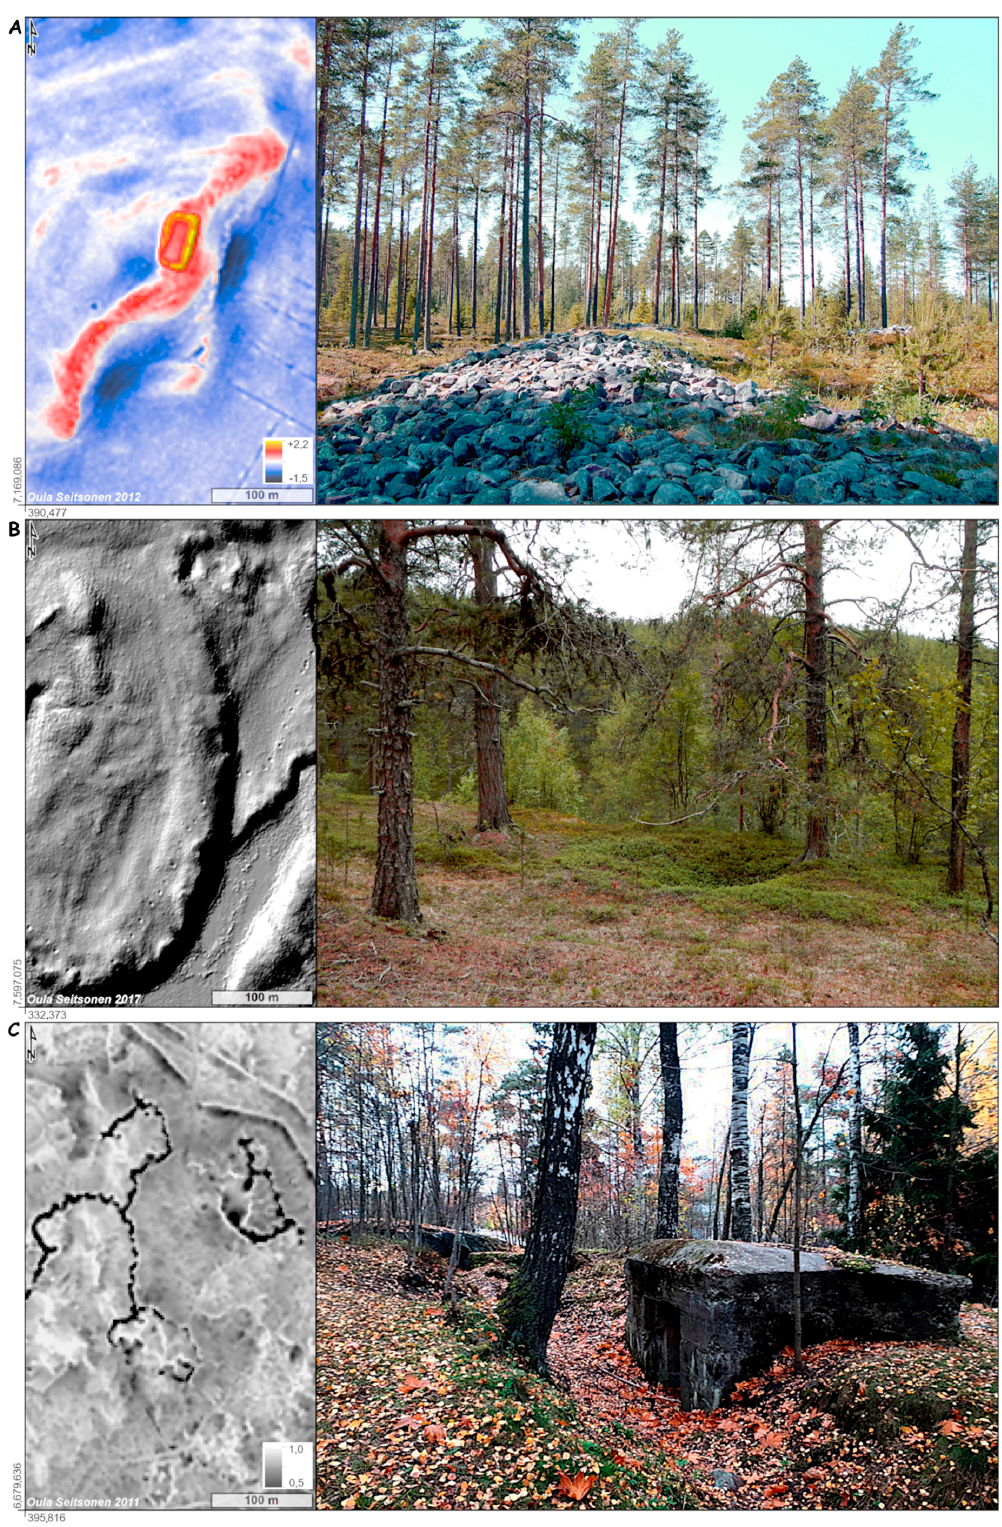
Figure 7. Visualizations and photographs of selected sites (in Finland) based on the open-access ALS data from the Finnish National Land Survey (FNLS). ( A ) Local relief model of a Late Neolithic